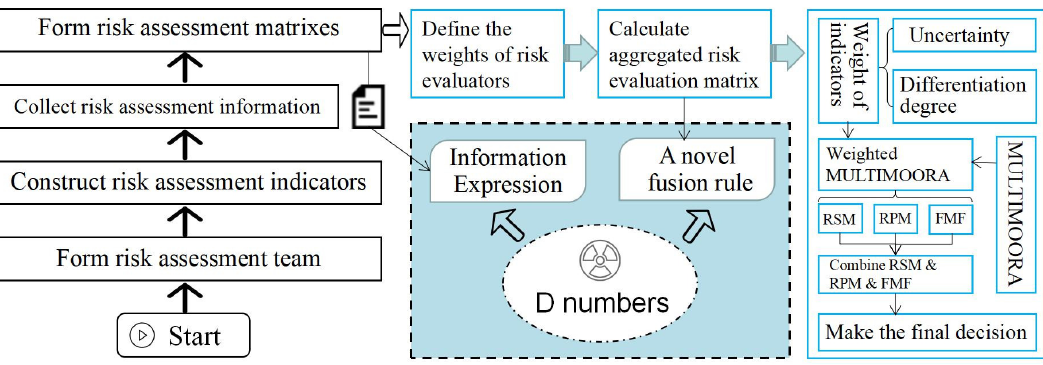
Figure 1. Process of the proposed risk assessment approach.